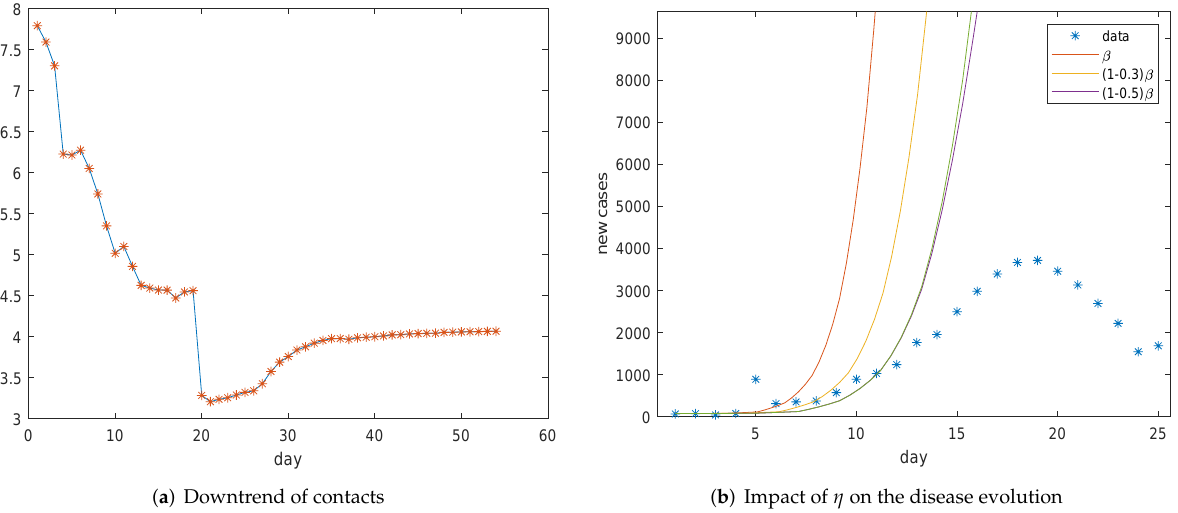
( b ) Impact of η on the disease evolution Figure 5. Contact infections decreased with interventions. ( a ) It can be seen that the ratio of cu- mulative tracked contacts to confirmed cases significantly decreased within half a month. ( b )